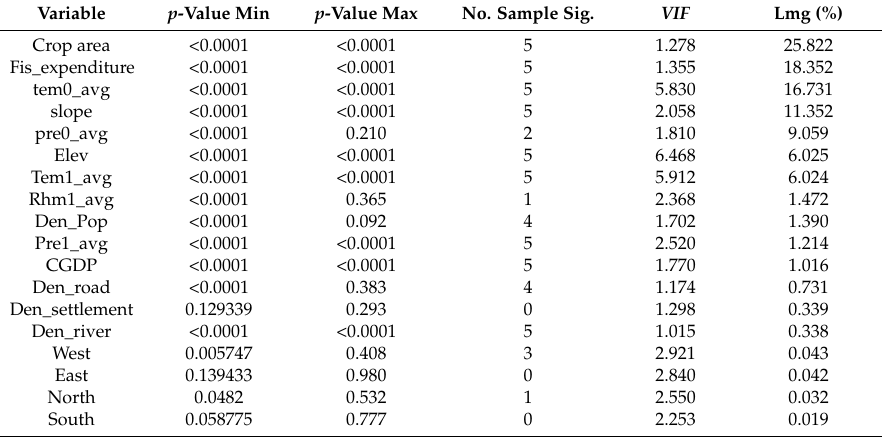
Table 3. The significance of variables in five intermediate models ( p -value) and the variable importance based on lmg (%) in MLR. “No. sample sig.” represents the number of samples where each variable is significant.